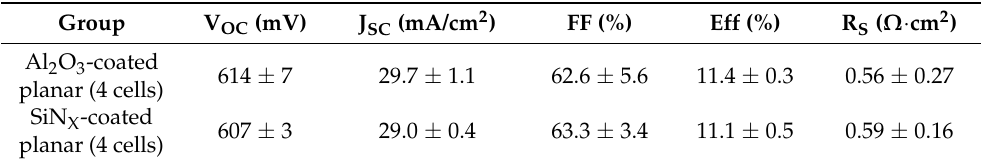
Table A1. The electrical parameters of previously fabricated planar solar cells with Al 2 O 3 (100 nm) and SiN X (80 nm)